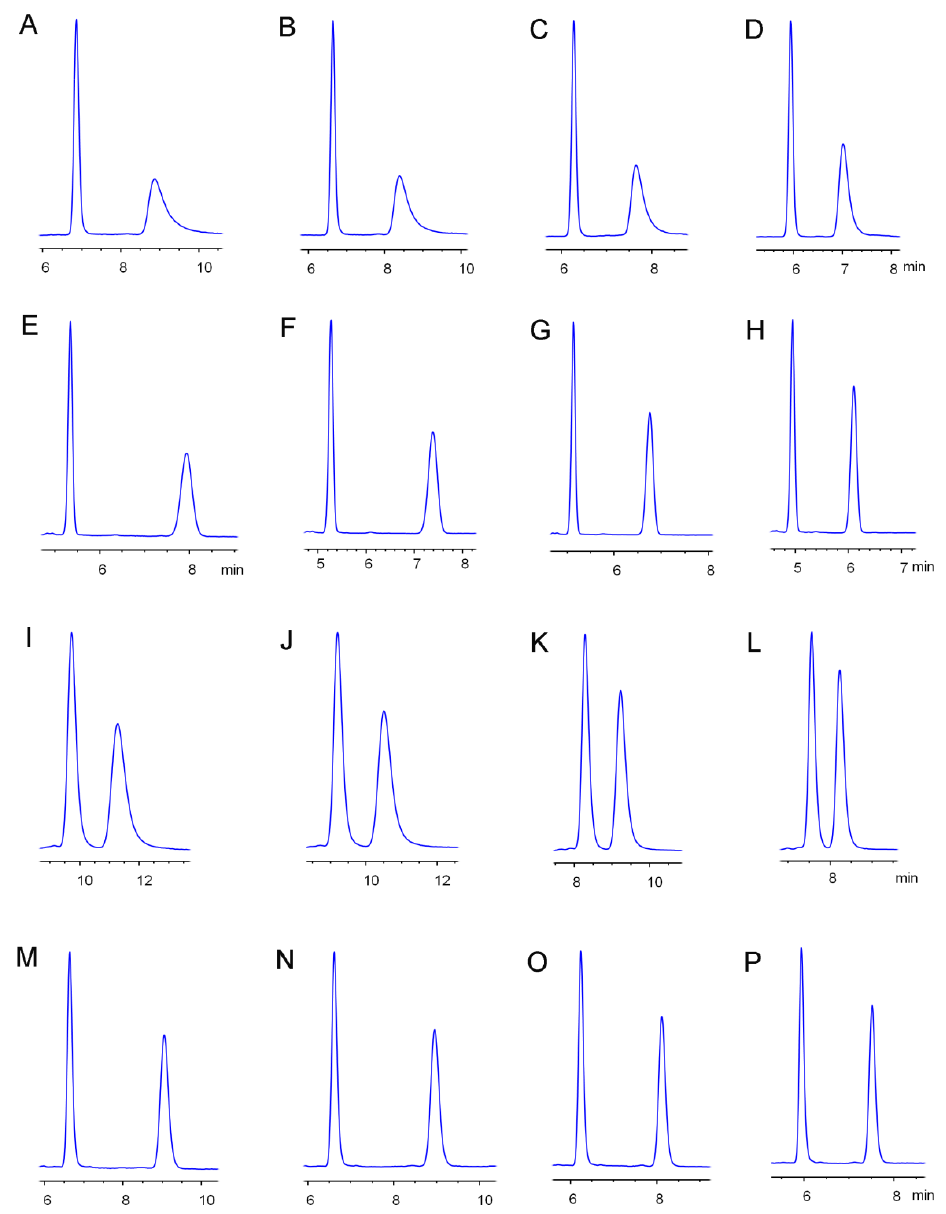
Figure 2. The e ff ects of temperature on etoxazole enantiomeric separation with Lux cellulose-1 (MEOH / H 2 O = 85 / 15, ( A ) 10 ◦ C, ( B ) 20 ◦ C, ( C ) 30 ◦ C, ( D ) 40 ◦ C), Lux cellulose-3 (ACN / H 2 O = 70 / 30, ( E ) 10 ◦ C, ( F ) 20 ◦ C, ( G ) 30 ◦ C, H 40 ◦ C), Chiralpak IC (MEOH / H 2 O = 90 / 10, ( I ) 10 ◦ C, ( J ) 20 ◦ C, ( K ) 30 ◦ C, Figure 2. The effects of temperature on etoxazole enantiomeric separation with Lux cellulose-1 ( L ) 40 ◦ C), and Chiralpak AD (ACN / H 2 O = 60 / 40, ( M ) 10 ◦ C, ( N ) 20 ◦ C, ( O ) 30 ◦ C, ( P ) 40 ◦ C) (MEOH/H 2 O = 85/15, A 10 °C, B 20 °C, C 30 °C, D 40 °C), Lux cellulose-3 (ACN/H 2 O = 70/30, E 10 °C, F 20 °C, G 30 °C, H 40 °C), Chiralpak IC (MEOH/H 2 O = 90/10, I 10 °C, J 20 °C, K 30 °C, L 40 °C,) and Chiralpak AD (ACN/H 2 O = 60/40, M 10 °C, N 20 °C, O 30 °C, P 40 °C) columns.